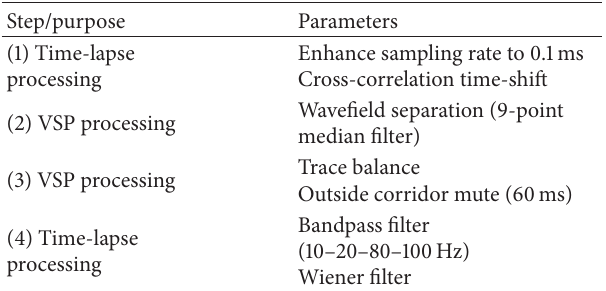
Table 3: Summary of the processing steps applied to the zero-offset VSP